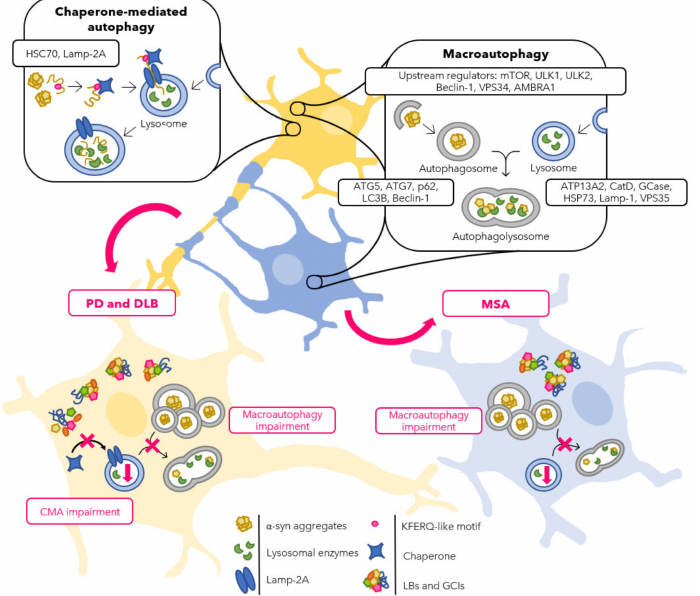
Figure 2. Schematic representation of the autophagic flux in neurons (yellow) and oligodendrocytes (blue) in normal and PD, DLB, and MSA conditions. Physiologically, both CMA and macroautophagy pathways are involved in protein degradation in the cytoplasm of neurons, whereas macroautophagy seems to be the more effective mechanism in oligodendrocytes. It has been reported that, in the context of ASPs, an impairment of the autophagic machinery is involved. PD and DLB neurons (bottom left) present with LBs in the cytoplasm accumulating α -syn together with other proteins that can be degraded by neither macroautophagy nor CMA, such as LRRK2, DJ-1, and UCHL1. Moreover, other autophagy-related proteins, such as AMBRA1, p62, and LC3B, accumulate in LBs. Eventually, macroautophagy impairment results in an accumulation of autophagosomes and reduction in lyso- somal activity. MSA oligodendrocytes (bottom right) show defects as well in the macroautophagic pathway with accumulation of GCIs containing α -syn, AMBRA1, p62, LC3B, and HSC70, together with an increased number of autophagosomes and diminished degradation in the